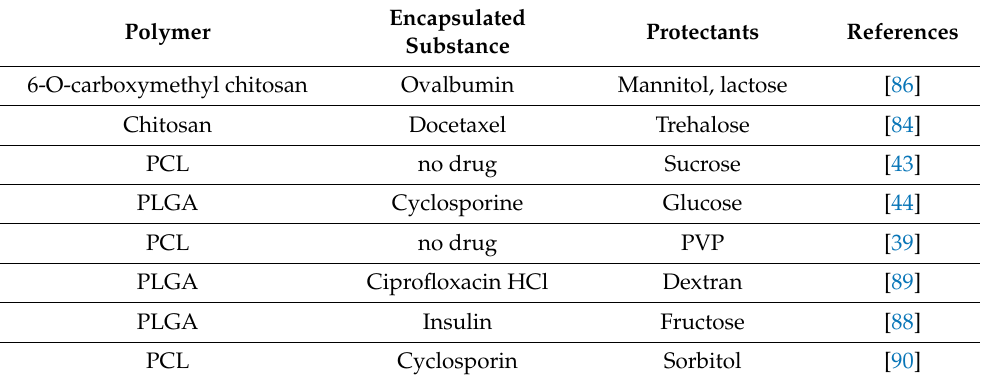
Table 5. Examples of freeze-dried nanocapsules and protectants most widely used in